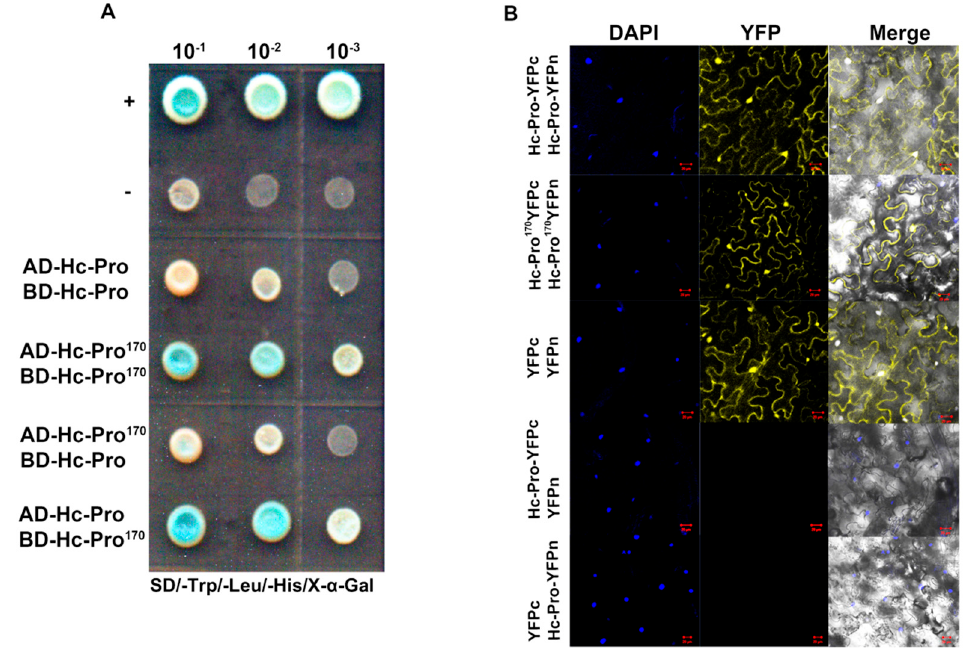
Figure 6. Yeast two-hybrid (Y2H) and bimolecular fluorescence complementation (BiFC) assays for Hc-Pro self-interaction. ( A ) Y2H assay. The yeast cells containing indicated constructs were grown on selective medium lacking leucine, tryptophan and histidine (X- α -Gal). The yeast concentration gradients were 10 − 1 , 10 − 2 and 10 − 3 , respectively. pGBKT7-p53 / pGADT7-RecT (positive control) is symbolized as “ + ”, and pGBKT7-p53 / pGADT7-lamin (negative control) is shown as “–”. ( B ) BiFC assay of Hc-Pro interactions in N. benthamiana . The full length Hc-Pro and truncated Hc-Pro 170 were transiently expressed by co-infiltration on N. benthamiana leaves. sYFPn plus Hc-Pro-sYFPc or Hc-Pro-sYFPn plus sYFPc was used as the negative control. At 3 dpi, YFP fluorescence imaging was performed by confocal laser-scanning microscopy (488 nm). DAPI staining was performed to show the nuclei.